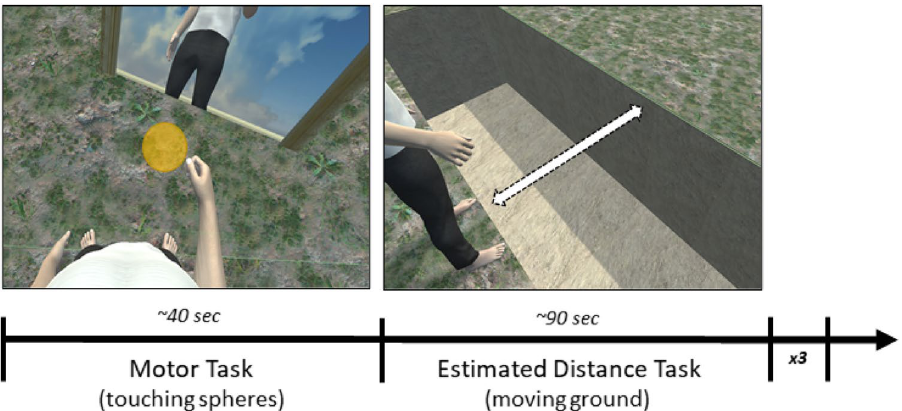
Figure 6. Study 2 Timeline including the Motor Task (touching the virtual spheres), the Estimated Distance Task (moving forward or backward the ground platform in front of them until it reached the maximum distance that participants thought they were able to jump